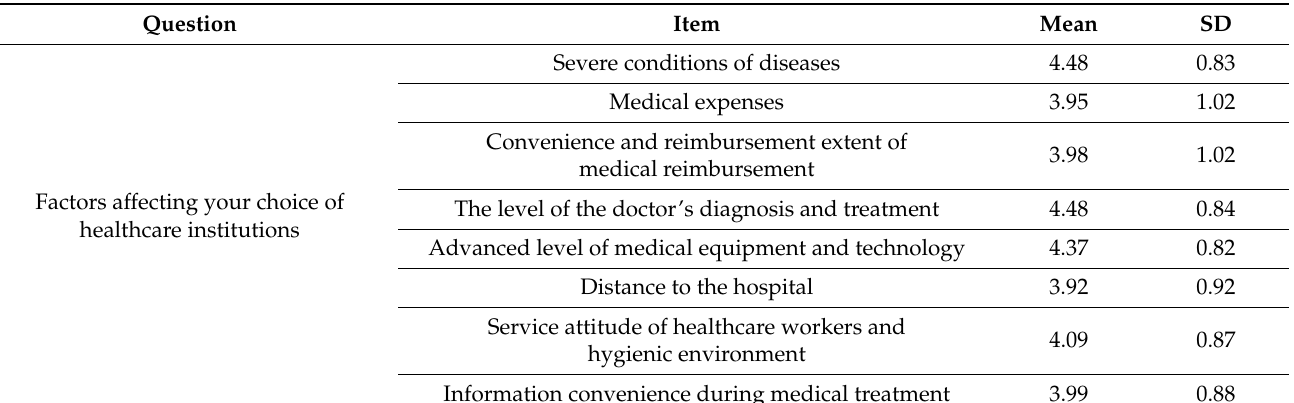
Table 8. Statistics on the importance of factors affecting medical behavior.